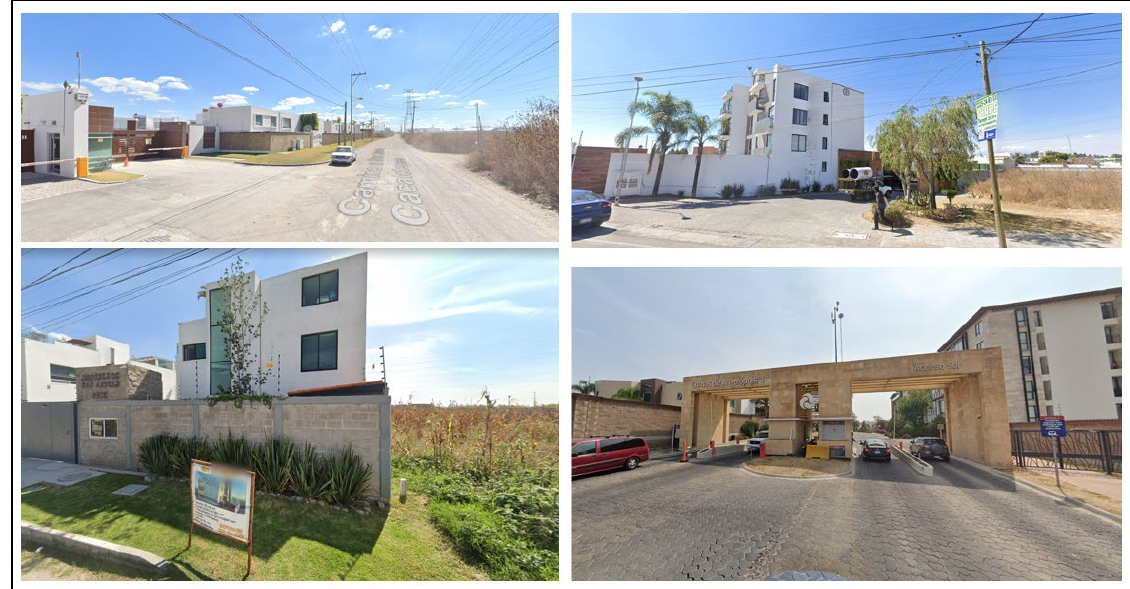
Figure 1. Images of gated communities across the area of study reflecting the idea of isolation from the context. Elaborated by Eduardo Gutierrez from Google Street View images. (2022).